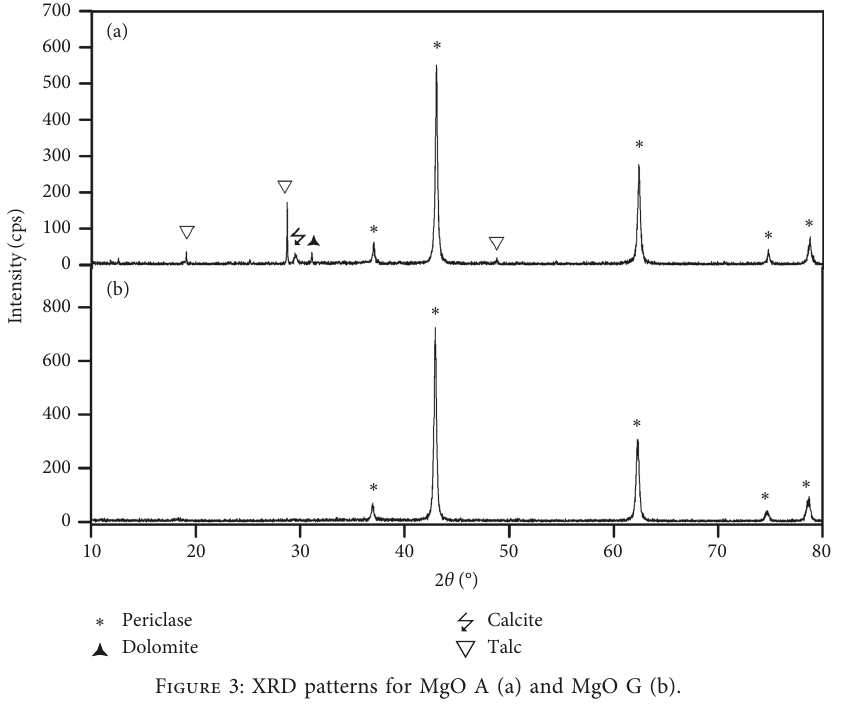
Figure 3: XRD patterns for MgO A (a) and MgO G (b).